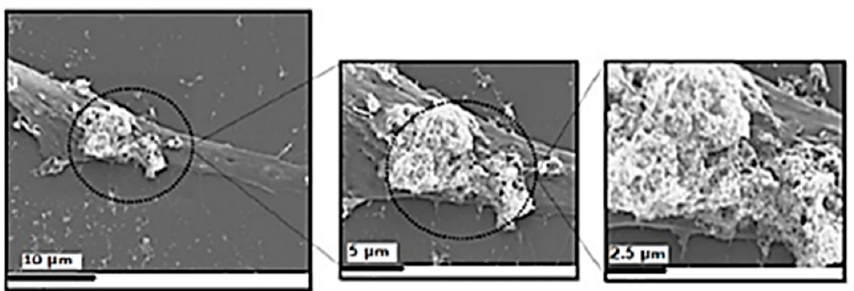
Figure 14. SEM images showing uptake and localisation of BPEI-coated IONRs inside the destroyed nucleus of a U87 cell at a concentration of 10 µ g/mL of BPEI-coated IONRs.